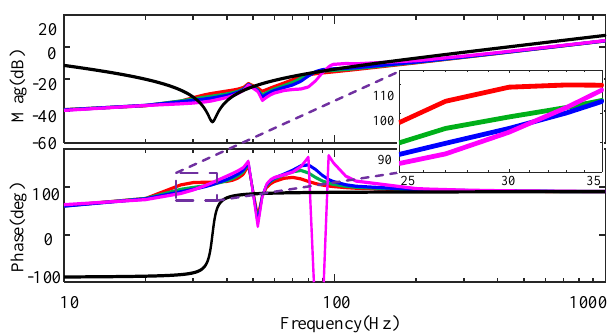
Figure 14. Bode diagram of different damping of reactive power. Red line: D Q 0 ; green line: 1.5 D Q 0 ; blue line: 2 D Q 0 ; pink line: 4 D Q 0 .